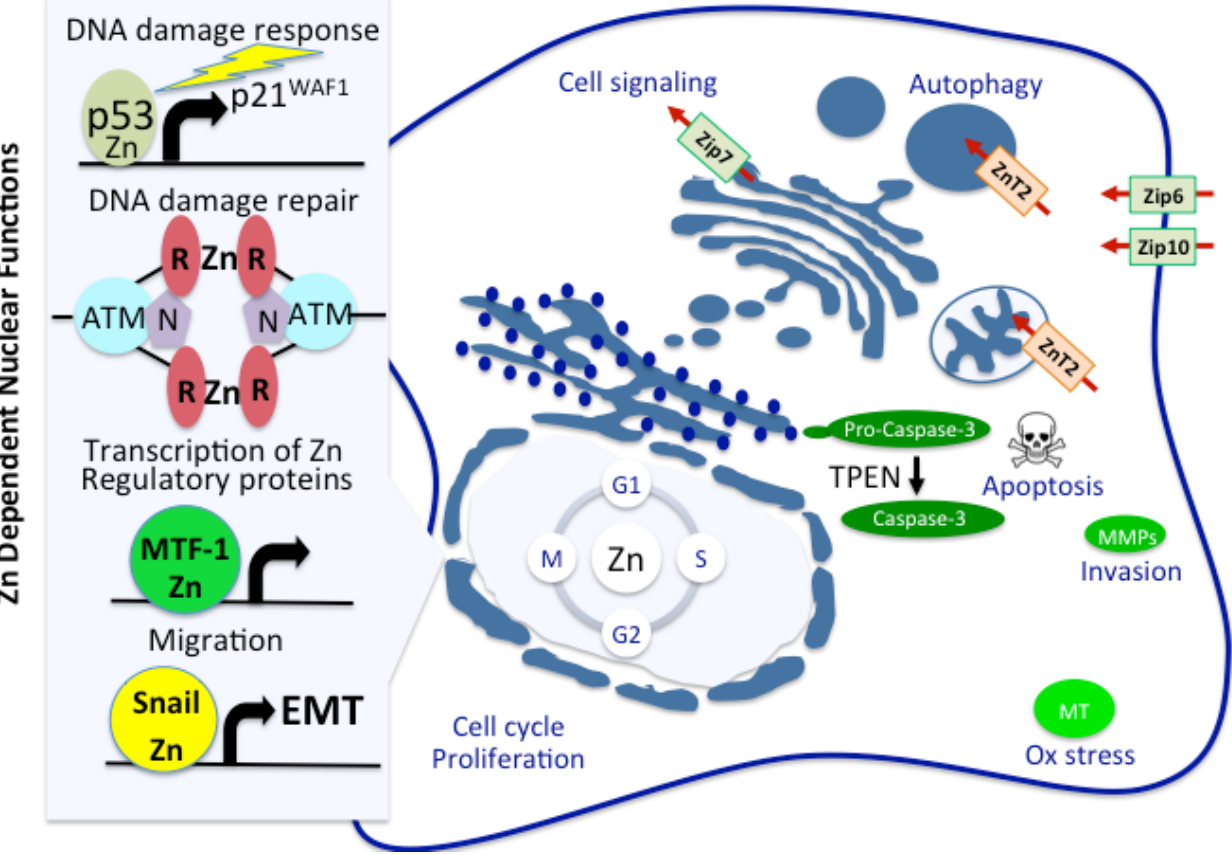
Figure 1. Homeostatic role of Zn in cellular functions which potentially link to initiation and progression of breast cancer. Zn is a biologically essential metal and is a cofactor for more than 300 enzymes and proteins involved in the defense against oxidative stress, including metallothionein, proteins controlling responses to DNA damage and repair (p53; ATM/MRN), intracellular signaling enzymes, more than 2000 transcription factors that require Zn for their structural stability and binding to DNA, also known as Zn-finger proteins, including MTF-1, which controls transcription of Zn regulatory proteins such as metallothionein (MT), and matrix metalloproteinases (MMPs), a family of Zn-dependent endopeptidases which regulate tissue remodeling. Zn also functions as an intracellular second messenger, cytosolic levels of which are tightly controlled by coordinate regulation of ZnTs and ZIPs. In addition, Zn is critical for cell proliferation, cell cycle regulation, differentiation and apoptosis. Cumulatively, the antioxidant and anti-carcinogenesis mechanisms associated with Zn homeostasis appear to play an inhibitory role on neoplastic cell